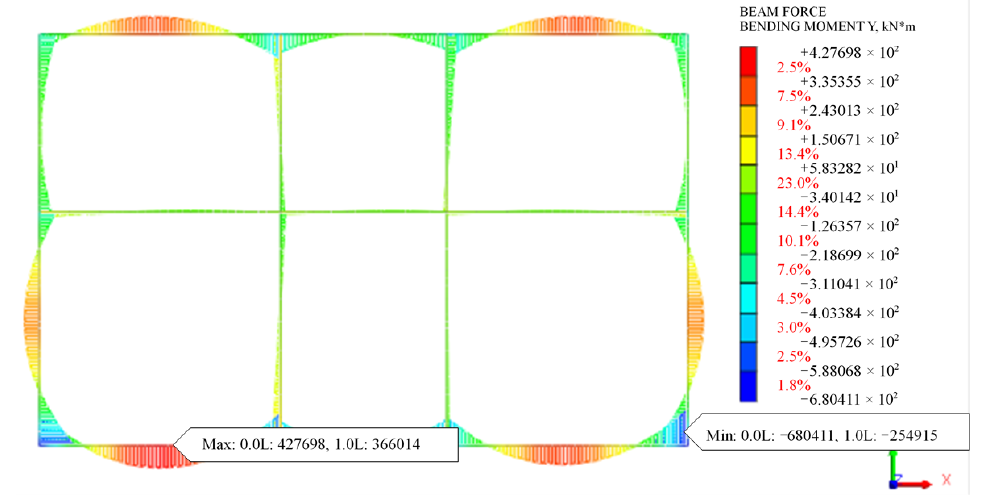
Figure 19. Internal force diagram of typical section structure before construction.